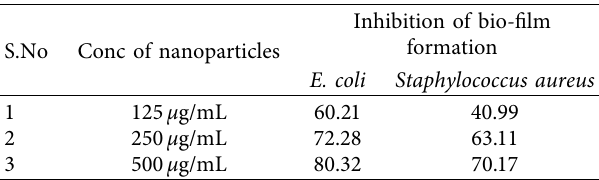
Figure 8: The antifilm activity of PA@AgNPs against human pathogens by crystal violet staining method using Escherichia Coli and Staphylococus aureus . Table 2: Antibiofilm assay of synthesized Nanoparticles using Escherichia Coli and Staphylococus aureus .